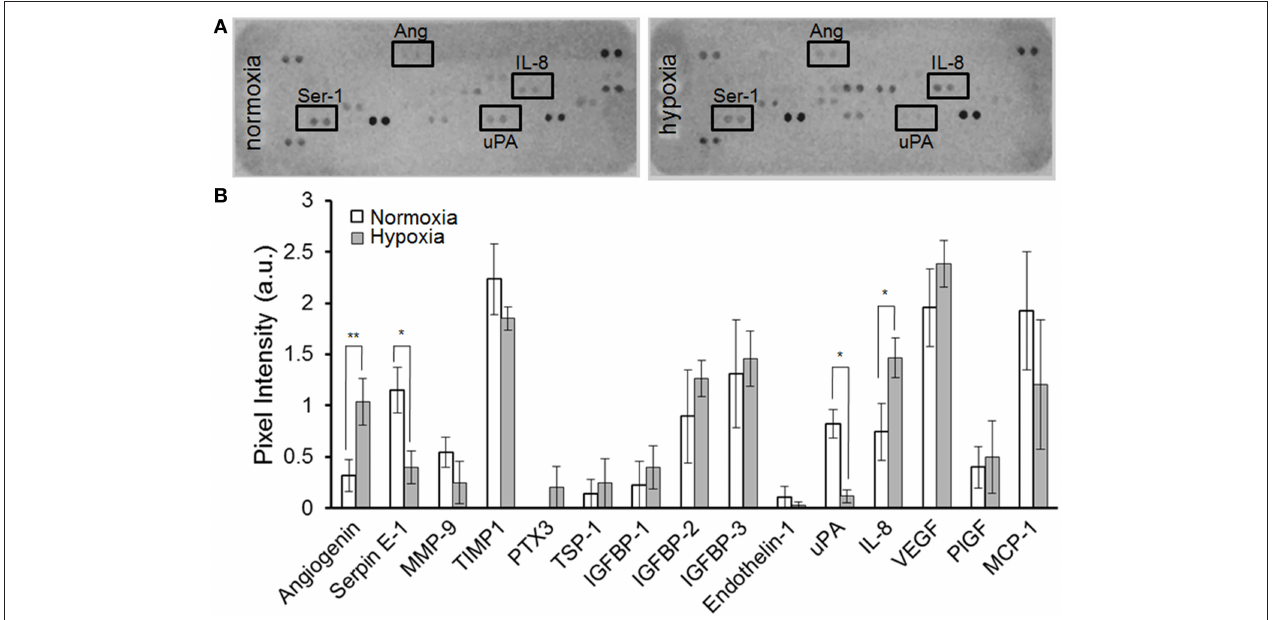
FIGURE 4 | MSC-containing SDR secrete angiogenic factors and respond to hypoxia. MSC-containing SDR were cultured under normoxic or hypoxic conditions for 2 days and supernatant collected for angiogenic factors as described in Section Materials and Methods. (A) Representative angiogenesis-proteome array. (B) Quantification of angiogenesis proteome array, using MSC from 3 different donors. * p < 0.05 ; ** p < 0.005